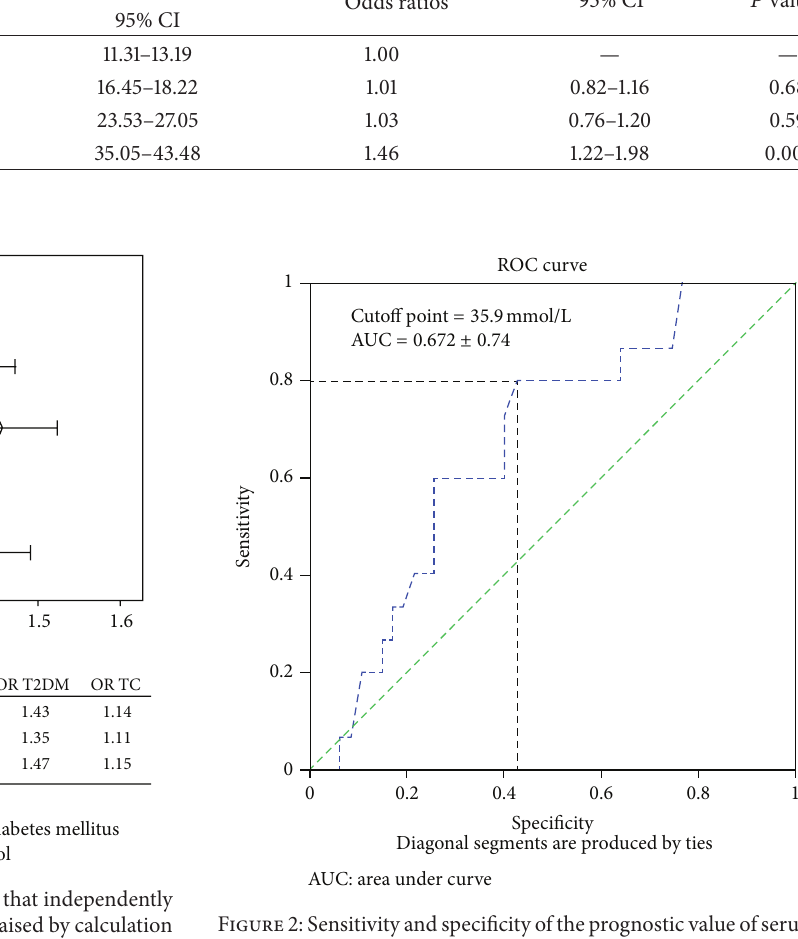
Figure 2: Sensitivity and specificity of the prognostic value of serum uric acid for coronary calcification. Results of ROC curves